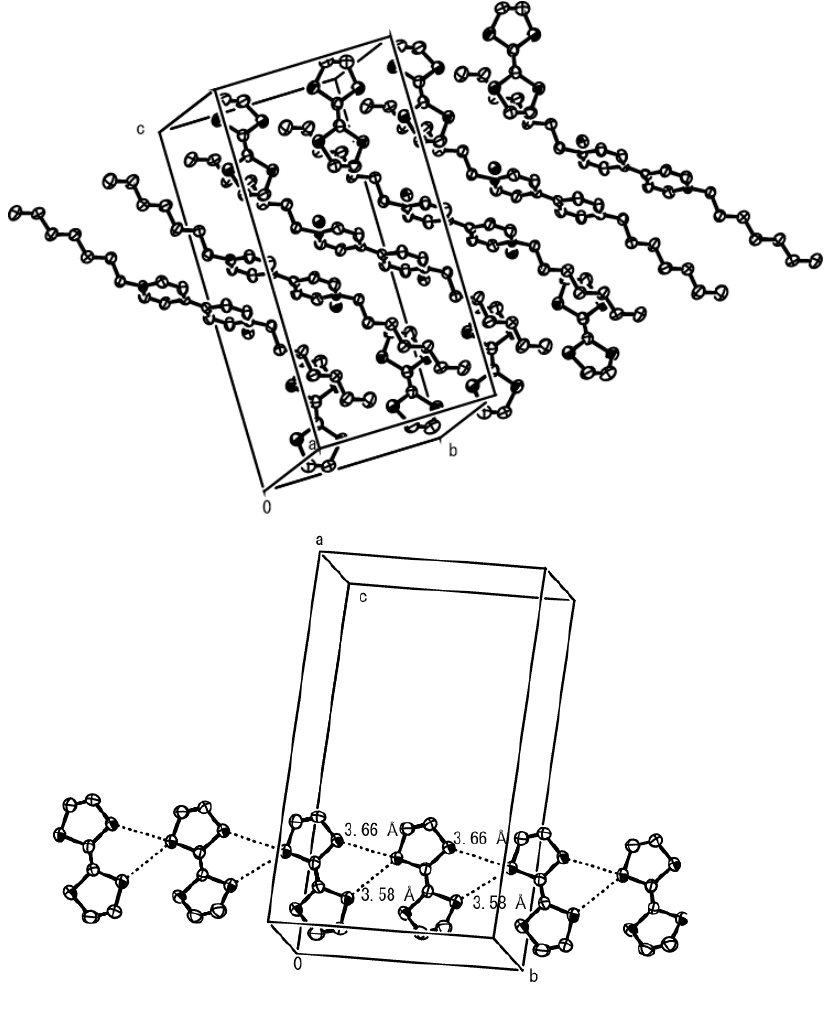
Figure 2. Upper: crystal structure of complex 5 . Lower: side-by-side arrangement of TTF molecules with indication of two kinds of short S-S